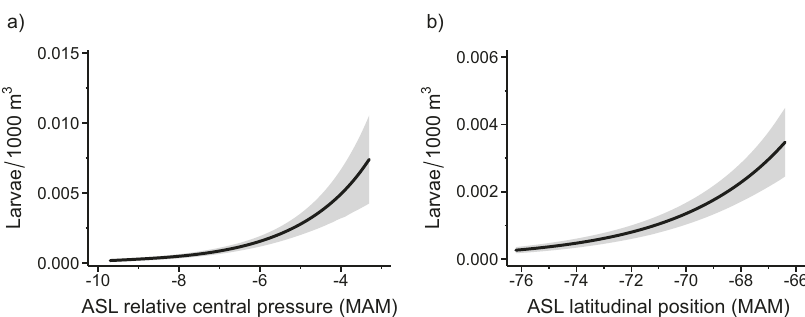
Fig. 4 Predicted impact of Amundsen Sea Low relative central pressure and latitudinal location on larval Antarctic Silver fi sh abundance. a , b Predicted impact (solid black lines) on larval Antarctic Silver fi sh abundance from a the relative central pressure (RCP) of the Amundsen Sea Low (ASL) during austral autumn (March – April – May [MAM]; p = 0.006) and b the latitudinal location of the ASL during austral autumn ( p = 0.004) from the model (see “ Methods ” ). Smaller RCP values correspond with stronger (i.e., deeper) ASL events and smaller latitudinal values correspond with southward (i.e., poleward) locations of the ASL. The ASL RCPs and locations were temporally lagged in the model to align with life history patterns in adult Antarctic Silver fi sh abundance. The shaded regions represent the 95% prediction interval, which considers uncertainty from the fi xed effects, zero-in fl ation, and random effects components of the fi nal model (Supplementary Fig. 2a 112 , see “ Methods ” ). It is important to note only one value of ASL RCP was greater (less negative) than − 4.5, which accounts for the increased uncertainty at less negative values (> − 4.5). Additionally, we observed no signi fi cant collinearity between ASL RCP and latitude in this analysis (see “ Methods